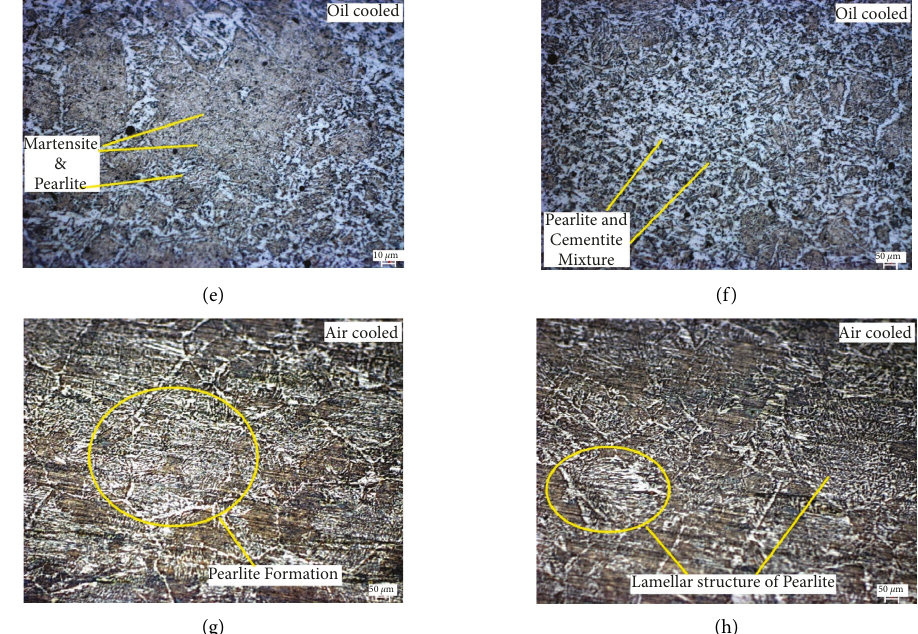
Figure 8: Polished welded plates and microstructures. (a, b) sand-cooled samples with coarse pearlite; (c) water-cooled sample with martensite formation; (d, e) oil-cooled sample possesses both pearlite and martensite as well as cementite-mix region; (f, g) air-cooled sample with lamellar structure of pearlite